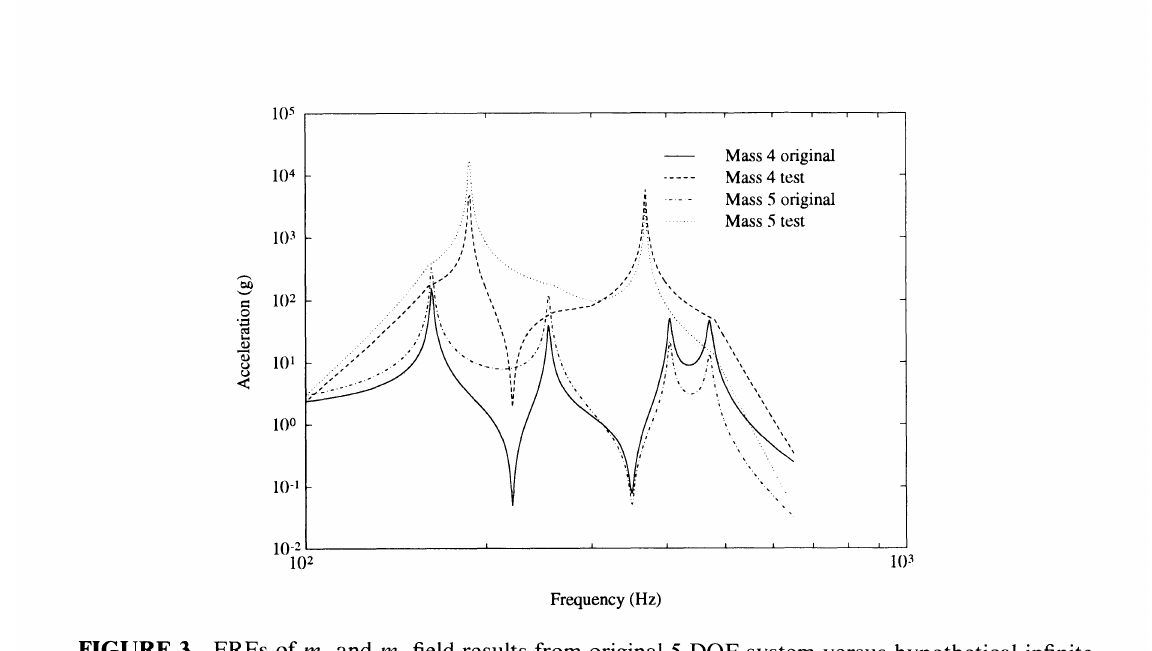
FIGURE 3 FRFs of m4 and ms field results from original 5-DOF system versus hypothetical infinite impedance equipment test